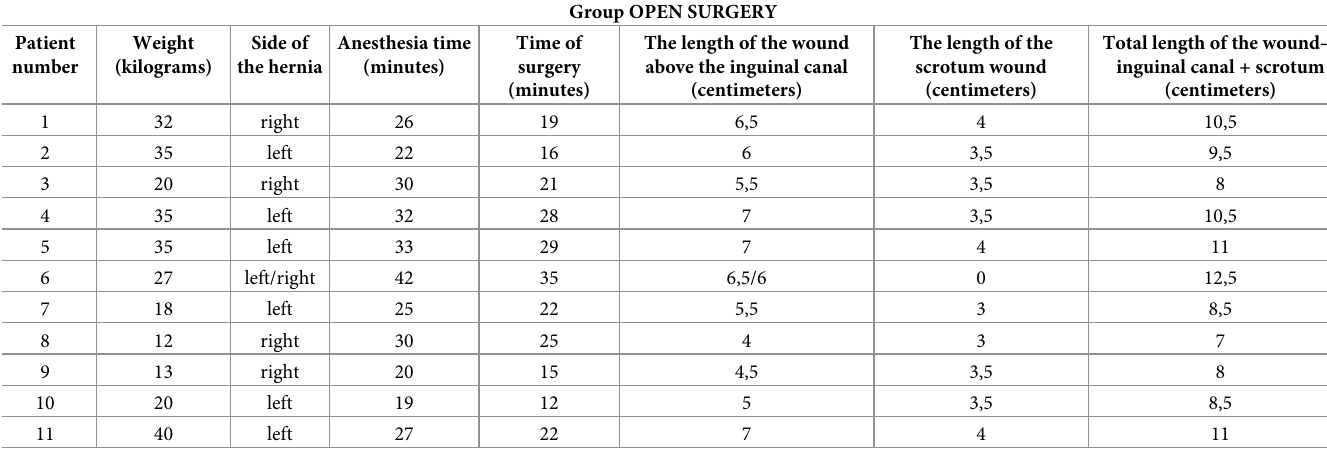
Table 1. Listing and additional information about operated pigs–open surgery group.